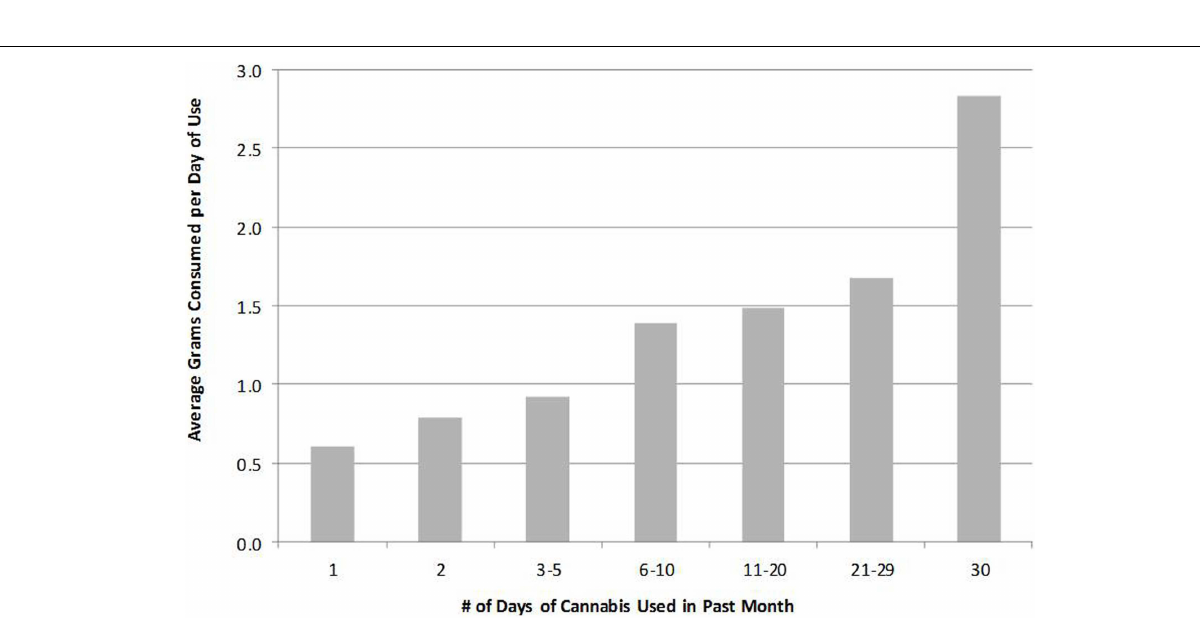
FIGURE 7 |Average quantity of cannabis consumed per day increases with frequency of cannabis use